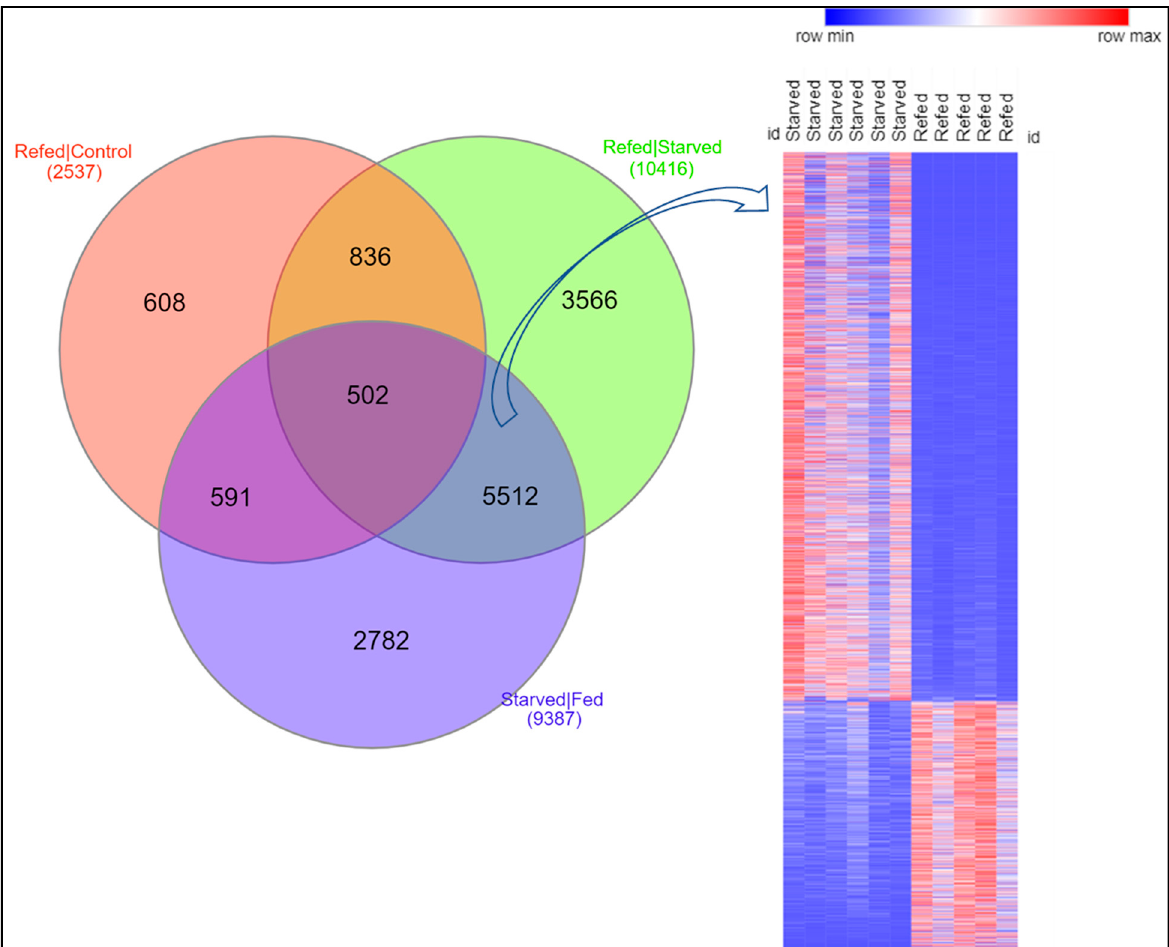
Figure 5. Venn diagram ( left ) showing the number of DE transcripts shared between different treatment groups, and heatmap ( right ) showing that refed fish reversed the expression of most of the DE transcripts in response to starvation. The expression pattern of fish sequenced for both total RNA and microRNAs (six starved and five refed) was displayed on the heatmap.